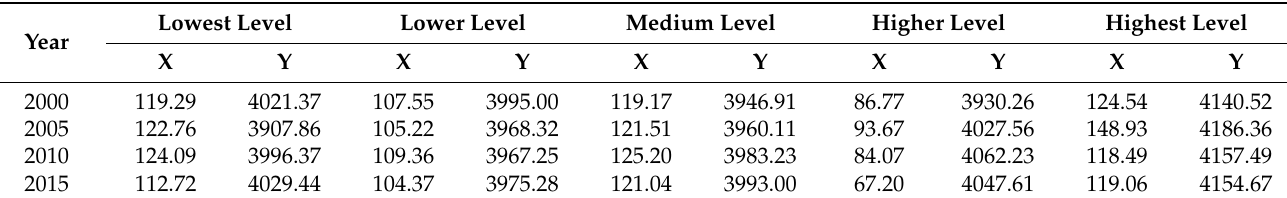
Table 5. Gravity center coordinates of different landscape ecological levels in Ningxia from 2000 to 2015 (Unit: km).